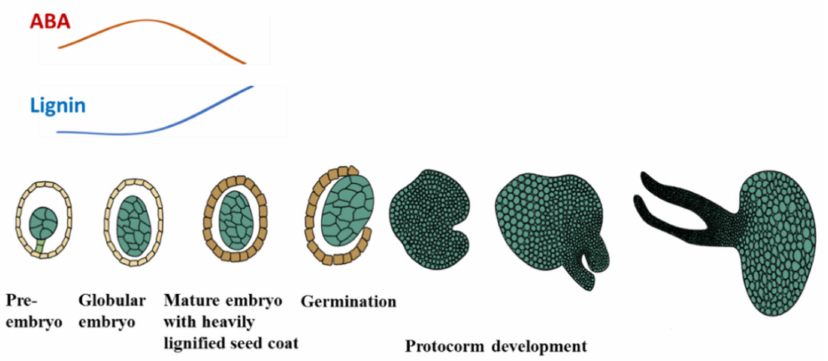
Figure 7. A schematic representation of embryo and protocorm development of P. armeniacum . P. armeniacum embryos developmental arrest at a stage comparable to the globular stage of Arabidopsis embryogenesis without obvious histodi ff erentiation. Seed coat lignification occurs before germination. Germination gives rise to a tubercle structure called a protocorm, from which the histodi ff erentiation occurs and the shoot apical meristem subsequently di ff erentiates. The high level of ABA inhibits the germination of immature seeds. Once the lignification rises [25], the ABA level starts to decline.